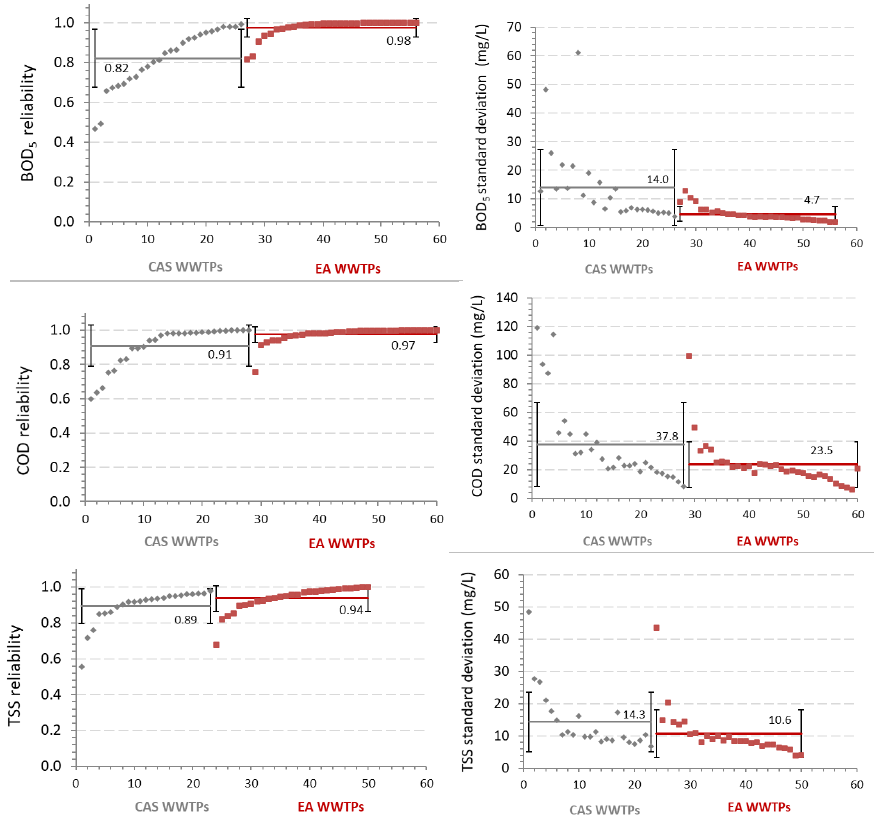
Figure 4. Plant annual reliability and standard deviation of BOD 5 , COD, and TSS effluent concentrations (each number in the x -axis corresponds to a given WWTP each year; 5-year data, 7 CAS-WWTPs and 9 EA-WWTPs).